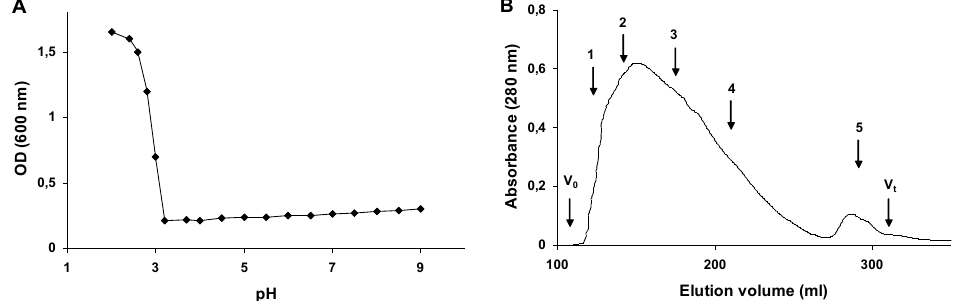
Figure 3. Solubility at different pH ( A ) and molecular weight determination ( B ) of the 2,5-DHBA– gelatin conjugate. ( A ) Turbidity of the conjugate solutions (optical density at 600 nm) at different pH values is presented; ( B ) The elution profile of the conjugate on HiLoad 26/60 Superdex 200 column. V o , void volume; V t , total column volume. Molecular weight markers: 1-apoferritin from horse spleen (443 kDa), 2-b-amylase from sweet potato (200 kDa), 3-alcohol dehydrogenase from yeast (150 kDa), 4-albumin, bovine serum (66 kDa), 5-carbonic anhydrase from bovine erythrocytes (29 kDa).